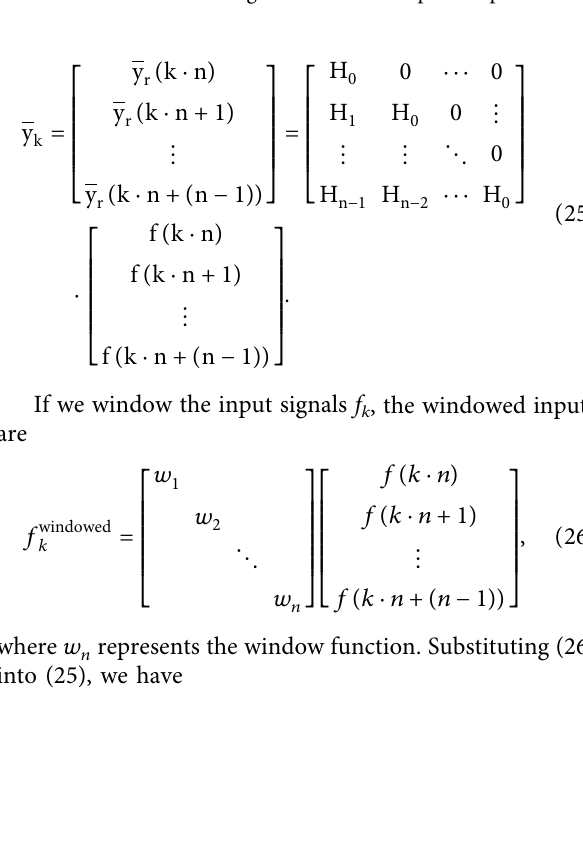
Figure 5: Schematic diagram of the overlap-add